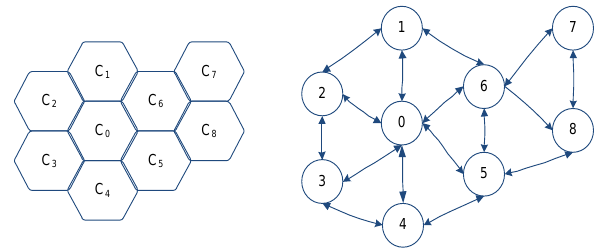
Figure 1. The simulation of the cellular network and graph G